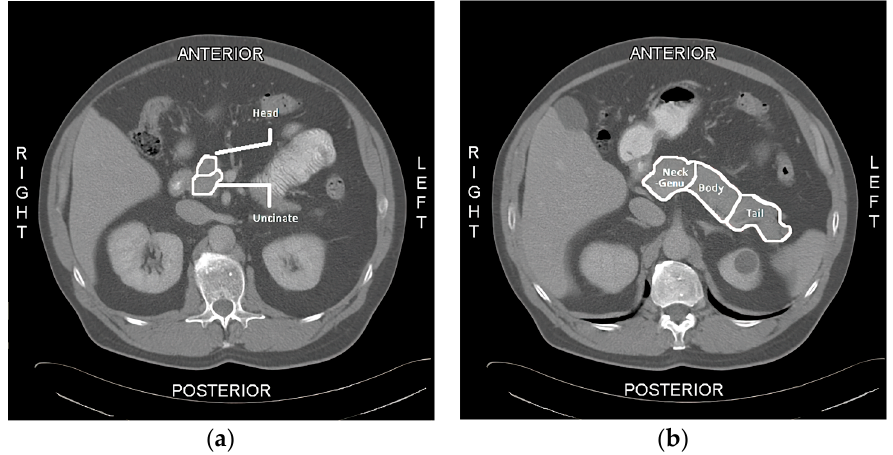
Figure 1. Regions of the Pancreas. This figure displays examples of the defined regions for the quantitative textural analysis (QTA) and fat quantification analysis of the pancreas: ( a ) the regions for the head and uncinate process of the pancreas; ( b ) the regions for the neck-genu, body, and tail of the pancreas. In this example, only 5 or the 7 ROIs are displayed.